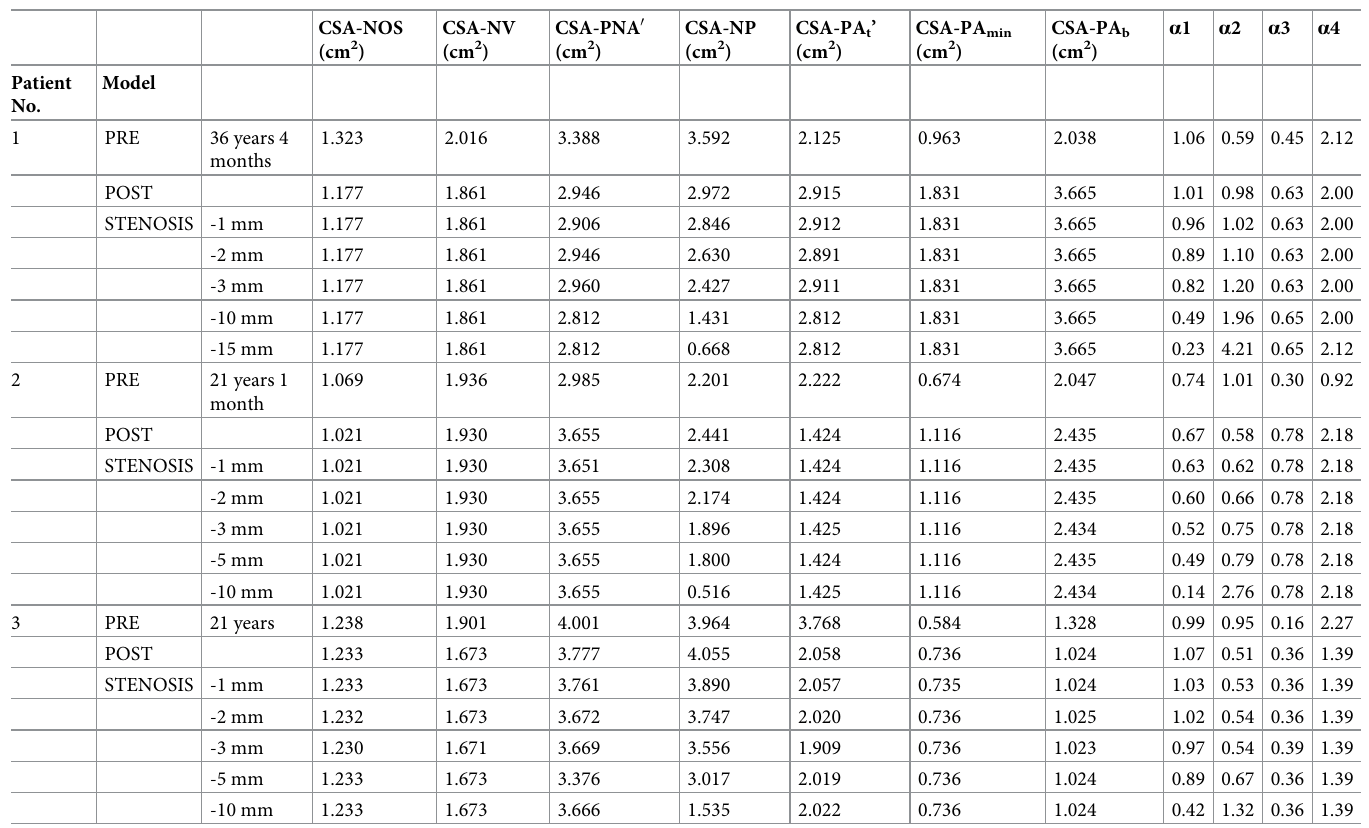
Table 4. Cross-sectional area and ratio of the cross-sectional